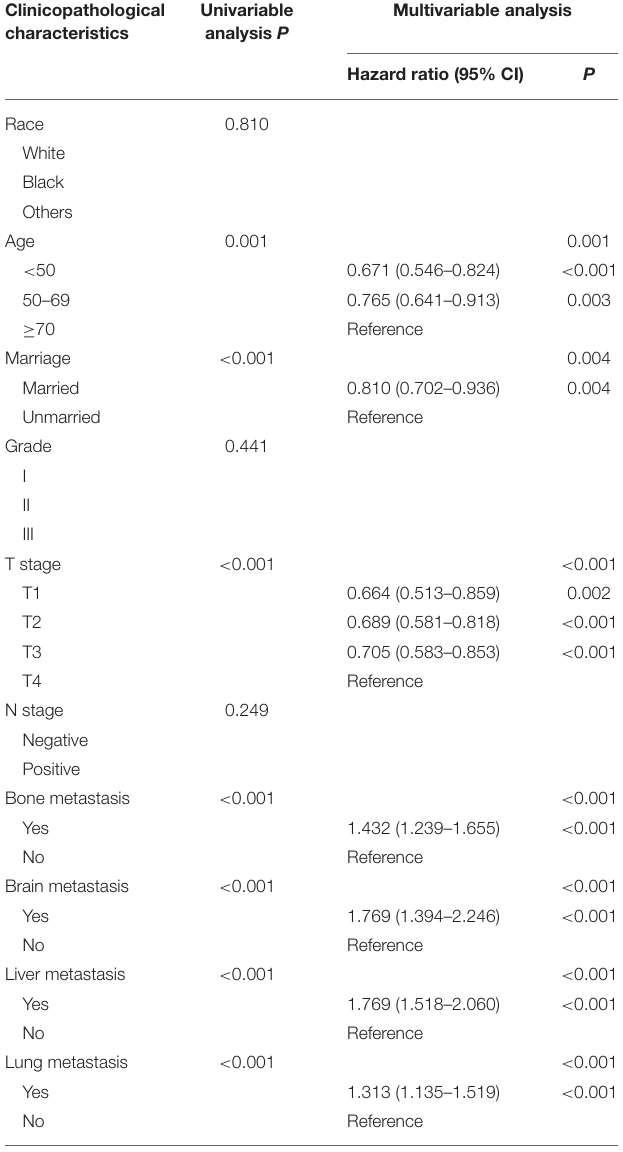
TABLE 2 | Univariate and multivariate analyses for overall